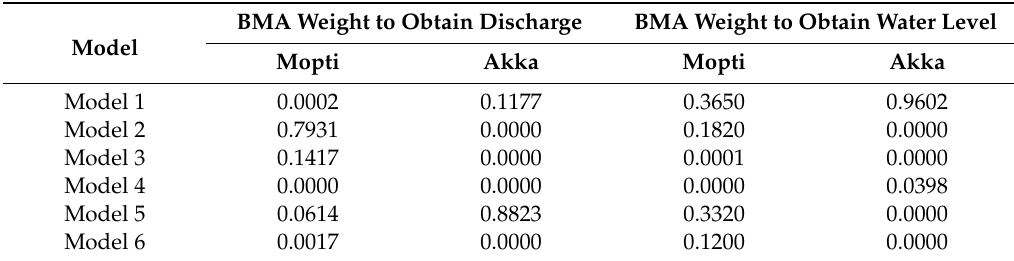
Table 9. Bayesian Model Averaging (BMA) weights of the